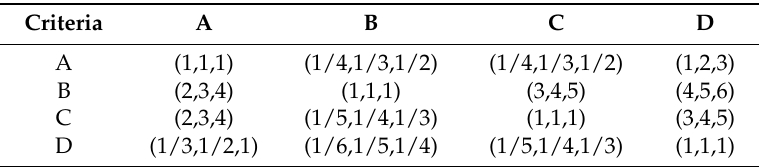
Table 3. Fuzzy comparison matrices for